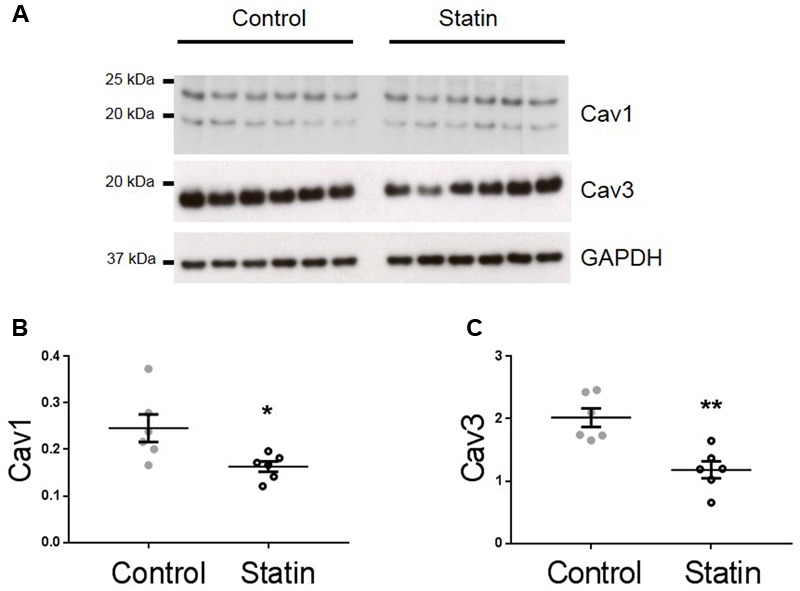
Simvastatin reduces expression of caveolins 1 and 3. Representative immunoblots (A) and scatter plots showing myocardial expression of Cav1 α (upper band) and β isoforms (B) and Cav3 (C). Plots show mean ± SEM from N = 6 animals per group. ∗P < 0.05, ∗∗P < 0.01 vs. control group, Student’s t-test.